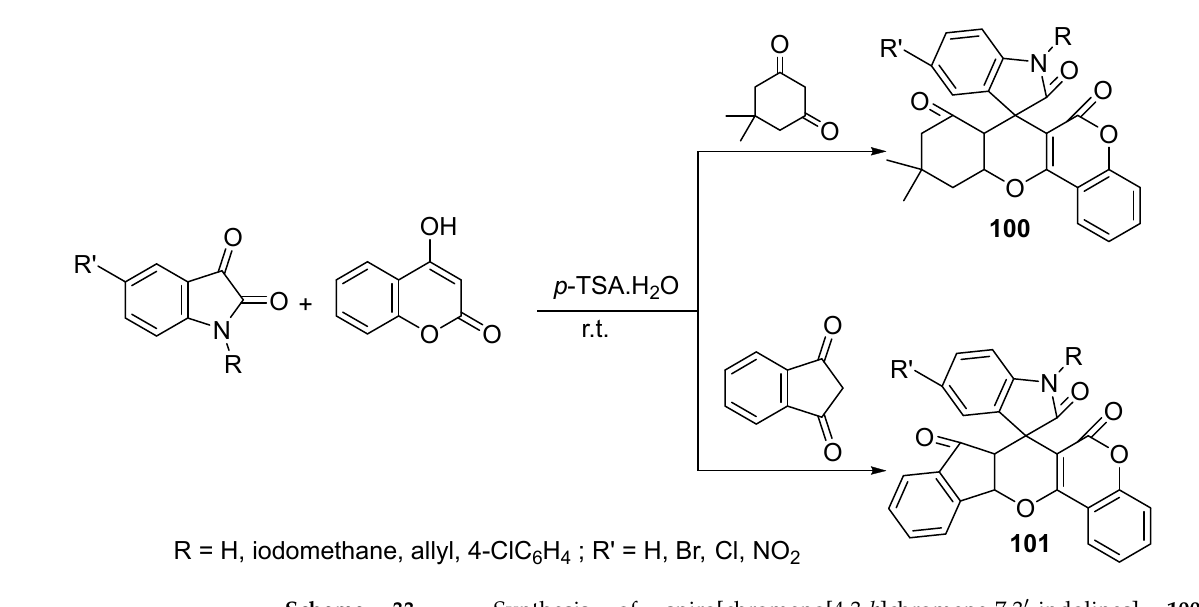
Molecules 2023 , 28 , 618 23 of 34 Scheme 32. Synthesis of spirocyclopropaneoxindoles 99 . A series of spiro[chromeno[4,3- b ]chromene-7,3 ′ -indolines] 100 and spiro[in- deno[2 ′ ,1 ′ :5,6]pyrano[3,2- c ]chromene-7,3 ′ -indolines] 101 were obtained through eco- friendly synthetic approach through the reaction of isatins, 4-hydroxycoumarin, and 5,5- dimethylcyclohexande-1,3-dione or 1 H -indene-1,3(2 H )-dione, respectively, in H 2 O in the presence of p -toluenesulfonic acid ( p -TSA.H 2 O) at room temperature (Scheme 33).